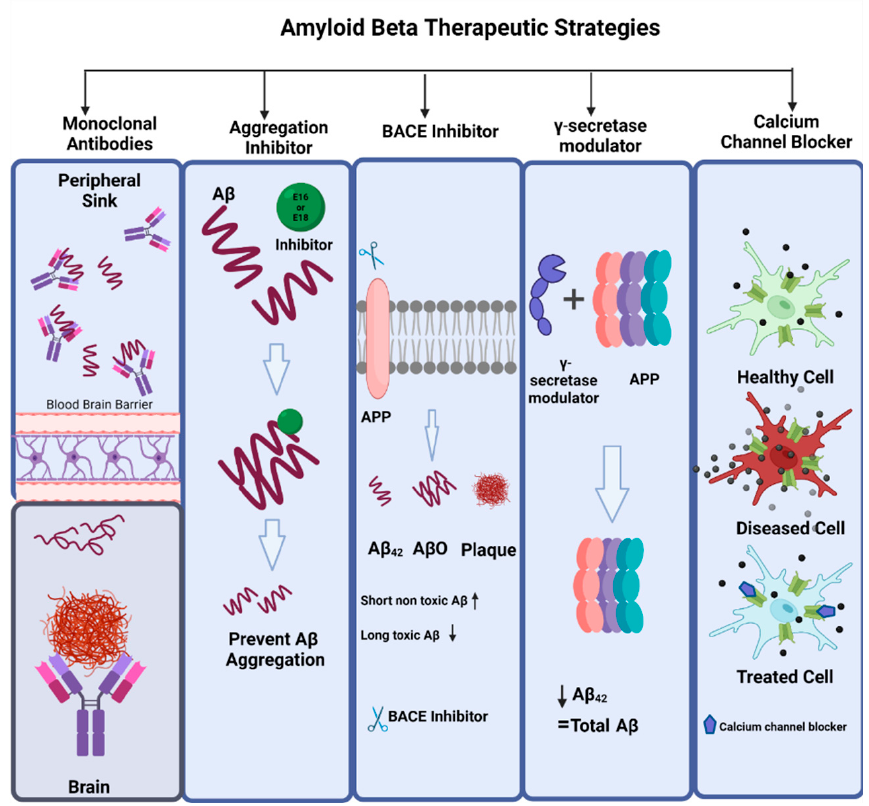
Figure 7. Amyloid beta therapeutic strategies. The commonly used therapeutic strategies for AD that targets amyloid beta are amyloid monoclonal antibodies, aggregation inhibitors (e.g., E16, E18), BACE inhibitors (e.g., CNP 520, MK8931, RIPK1), γ -secretase modulators, and calcium channel blockers (isradipine, nimodipine, verapamil, diltiazem).